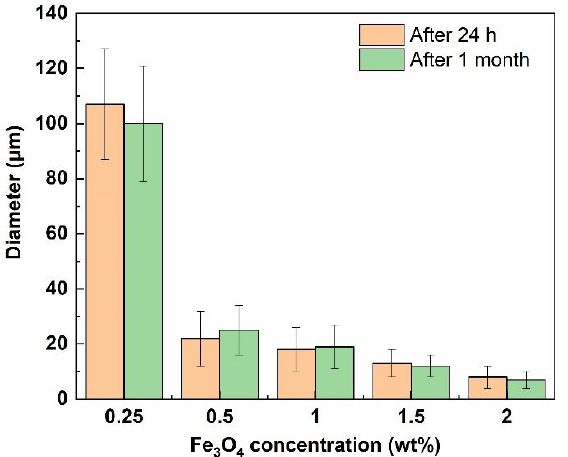
Figure 8. The mean droplet size of Pickering emulsions after 24 h and after 1 month of storage at different stabilized DC-Fe 3 O 4 concentrations. The liquid paraffin and water were in an equal volume ratio.